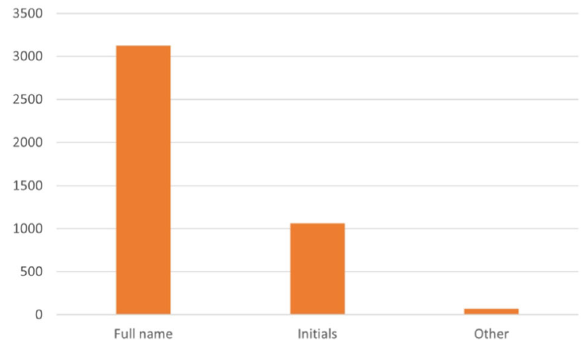
Fig. 3 Self-identi fi cation of issuers as inscribed on mid-17th century tokens in London. This chart details how token issuers inscribed their names . Those included here under “ Full name ” sometimes added initials in addition to their name. Those included under “ initials ” in this chart did not include a full name (below is a more detailed explanation). Tokens under the category “ other ” include tokens with no names, names of businesses, or names that could not be de fi ned as male or their legal status throughout the period. The results of this research are preliminary in that they look at female token issuers as a group. More archival research on individual female issuers could shed light on their professional and personal stories.